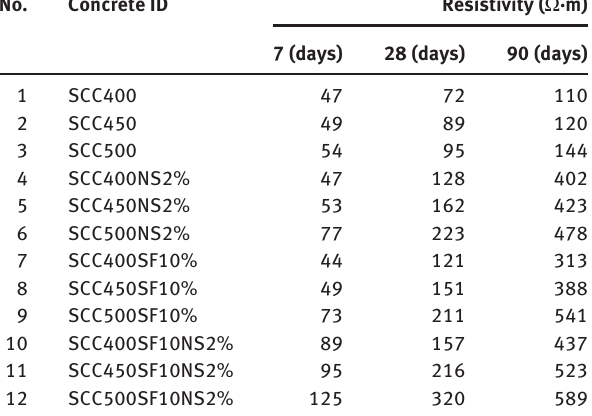
Table 8 Results of electrical resistivity for different